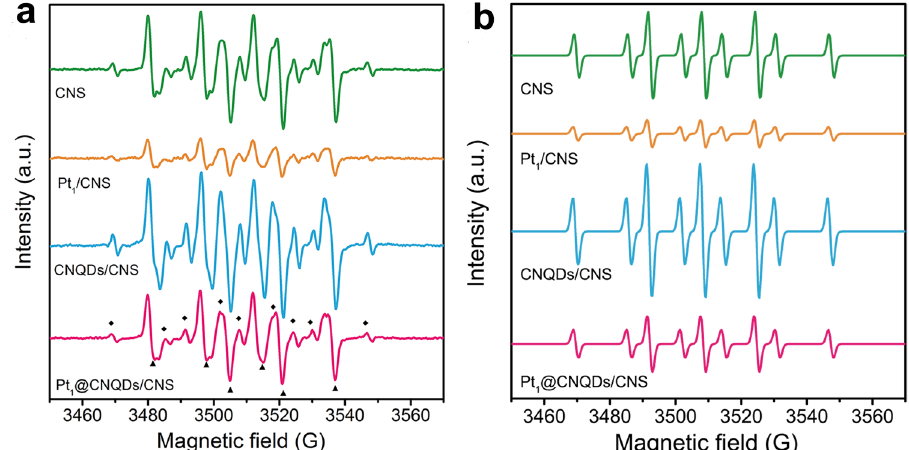
Fig. 4 In situ EPR on intermediates. a Experimental EPR signals of DMPO spin adducts generated under irradiation of a 300 W Xe lamp ( λ > 400 nm) and b the deconvolution DMPO-H spectra according to the experimental signal in a diagram recorded for the CNS, Pt 1 @CNS, CNQDs/CNS, and Pt 1 @CNQDs/ CNS.